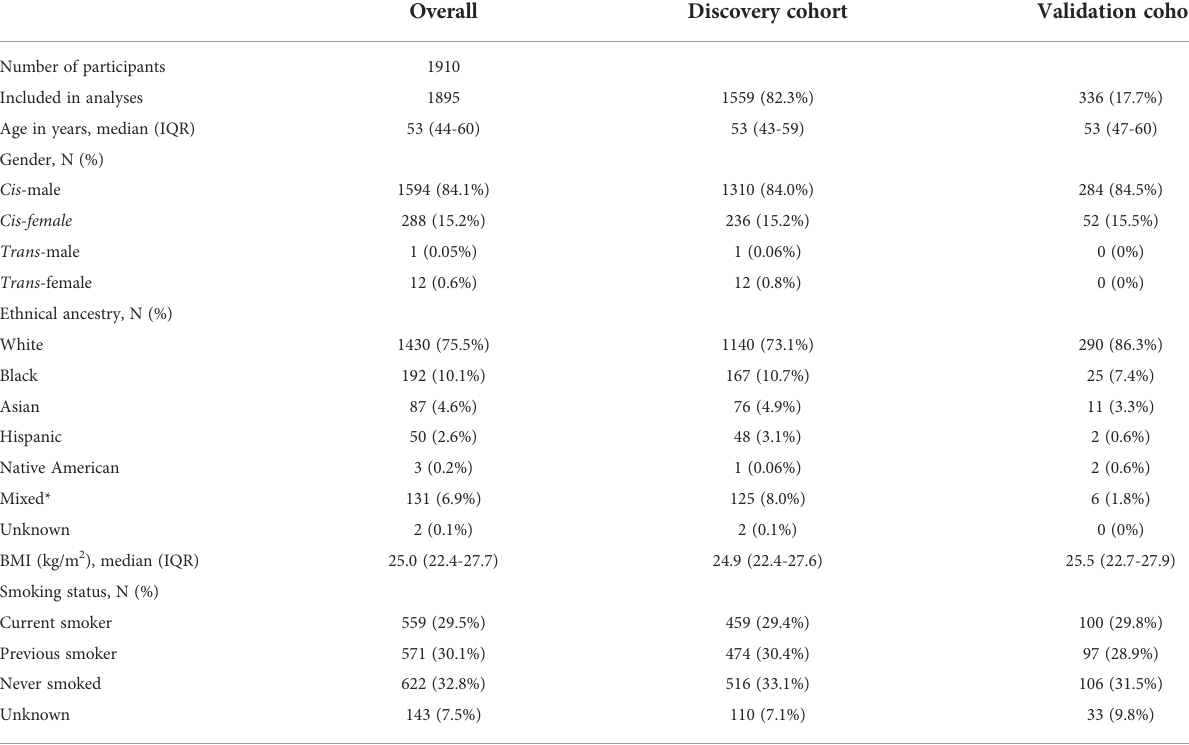
TABLE 1 Baseline characteristics of the study